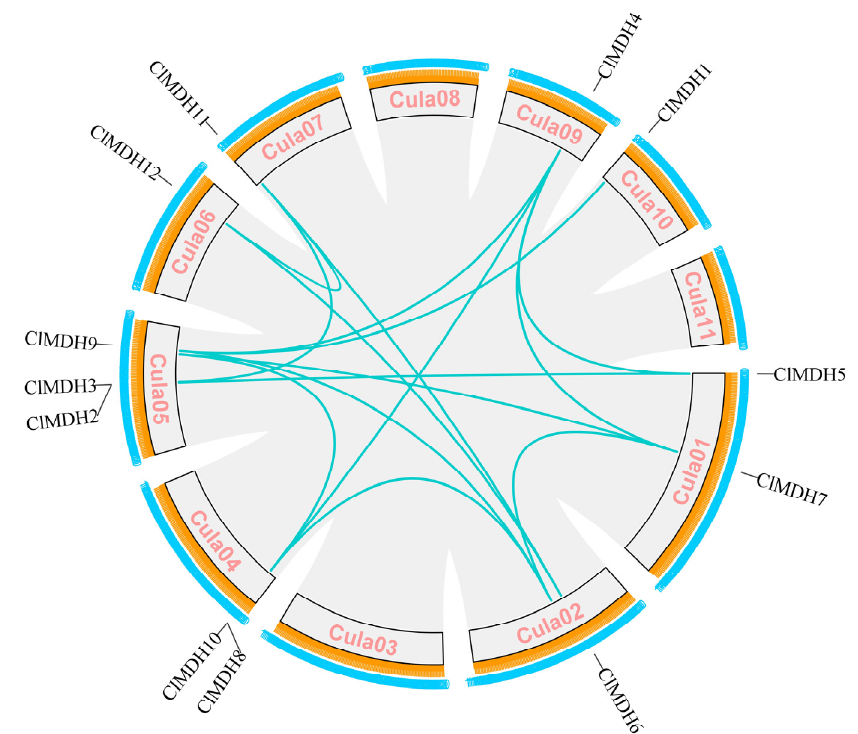
Figure 6. Circos illustrations of the gene duplication of ClMDH genes, the background gray lines show all syntenic blocks in the Chinese fir genome, and the red lines show the segmental or tandem duplication line regions among ClMDH genes. The approximate location of ClMDH genes is labeled with a short gray line outside the chromosome with gene names.